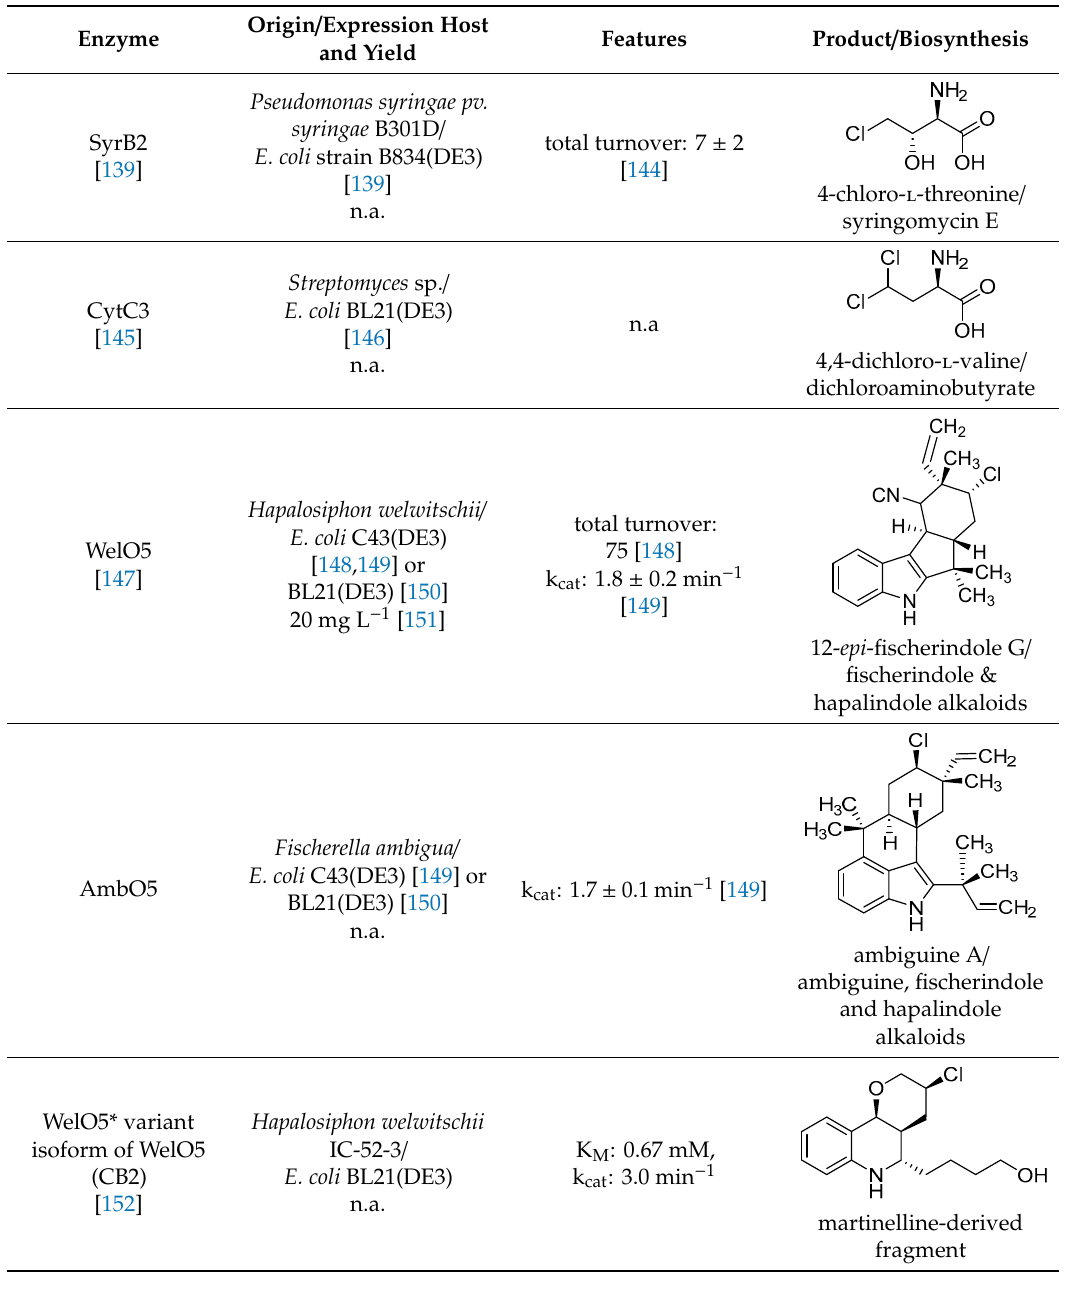
Molecules 2019 , 24 , x FOR PEER REVIEW Table 4. Examples of heterologously expressed Fe(II) / α KG-dependent halogenases. Origin / Expression Host Enzyme and Yield Pseudomonas syringae pv. SyrB2 [139]